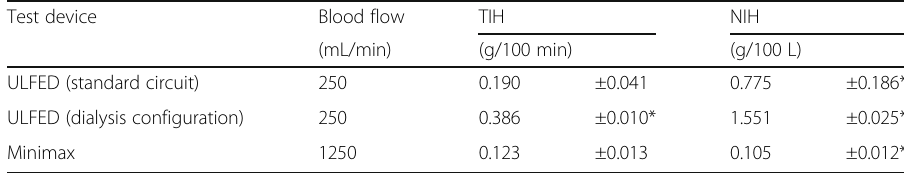
Table 1 Summary of in vitro hemolysis testing Test